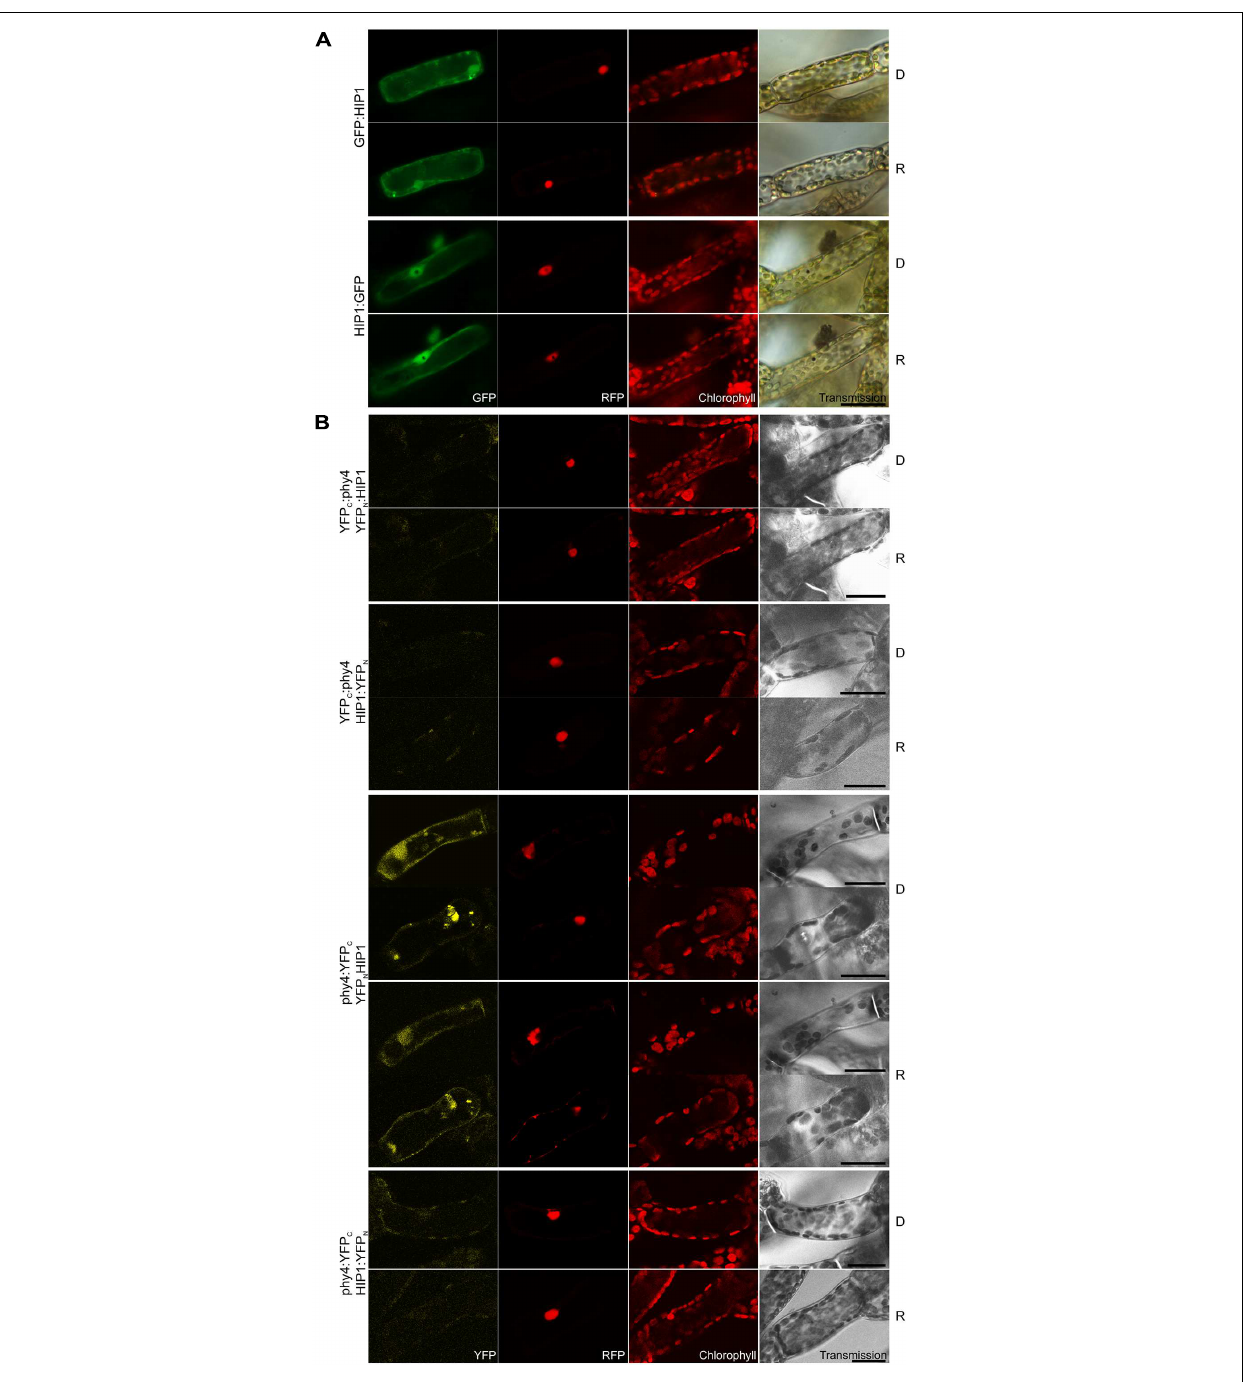
FIGURE 1 | HIP1 (Pp3c2_10320V1.1) intracellular localization (A) and split-YFP-studies of HIP1–phy4 interaction (B) each without (D) and with red pre-treatment (R) using fluorescence- and confocal microscopy, respectively. (A) Green fluorescence of N- and C-terminal HIP1:GFP fusions monitored by GFP (column 1) and was visible in nucleus and cytoplasm in both cases; Red fluorescence of the co-transfected mCherry:NLS nuclear marker (RFP) is shown in column 2; Chlorophyll autofluorescence (chlorophyll) and a differential interference contrast image (DIC) is shown in columns 3 and 4, respectively. For each FP configuration cells were photographed before (D) and after red light pre-treatment (R). The apparent “hole” in the nucleus of the HIP1:GFP fluorescence images and the corresponding black dot in the DIC images represents a large gold particle. (B) All possible split-YFP configurations were analyzed without (D) and with red pre-treatments (R) via confocal microscopy as shown in column 1: YFP C :phy4–YFP N :HIP1 (rows 1 + 2), YFP C :phy4–HIP1:YFP N (rows 3 and 4), phy4:YFP C –YFP N :HIP1 (rows 5–8) and phy4:YFP C –HIP1:YFP N (rows 9 and 10) . Analogous to panel (A) , columns depict (from left to right) YFP fluorescence, RFP fluorescence from mCherry:NLS, chlorophyll autofluorescence and a transmission image. Two different signal patterns were observed for phy4:YFP C –YFP N :HIP1, thus representative images are shown for each. Other configurations yielded only background signals alongside channel bleed-through. Scale bars 30 µ m.